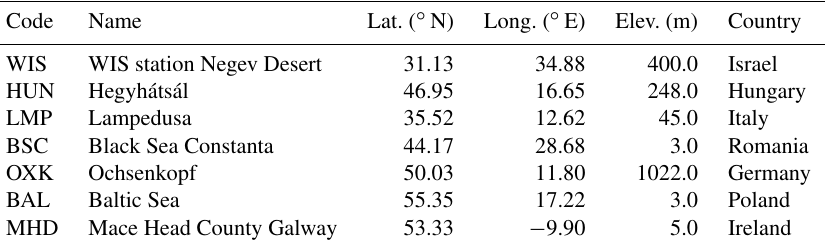
Table 3. Locations and elevations of NOAA Earth System Research Laboratory Global Monitoring Division (ESRL/GMD) background sites for CO measurements plotted in Fig. 19.